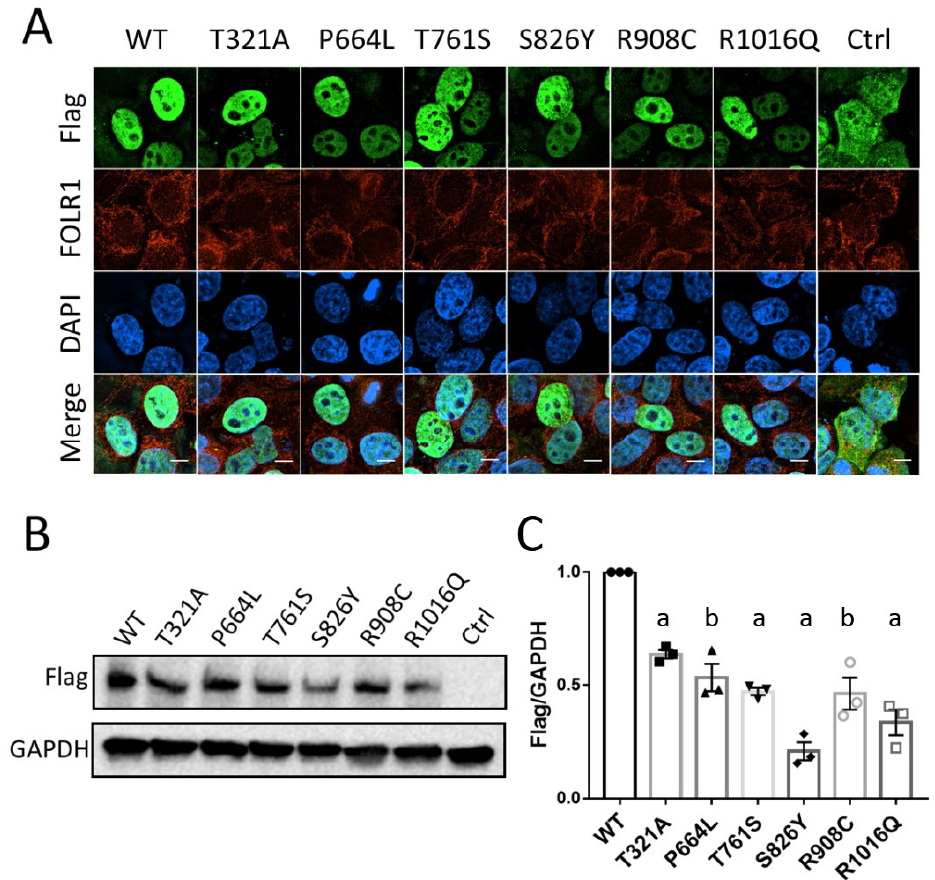
Figure 2. Subcellular localization and protein abundance of KDM6B wildtype and KDM6B mutant. ( A ) HeLa cells were transfected with mutated and wild ‐ type constructs of Flag ‐ tagged KDM6B and pcDNA3.1 backbone vector for 36h and were imaged under deconvolution microscope. Scale bar 5um. ( B ) Western blotting was performed in HeLa cells 48h post transfection. GAPDH was used as loading control. ( C ) Western blotting was repeated three times and a Student t ‐ test was performed to compare the protein level between wild ‐ type and mutant. Significance compared to WT: “a” represents p < 0.001; “b” represents p < 0.01.